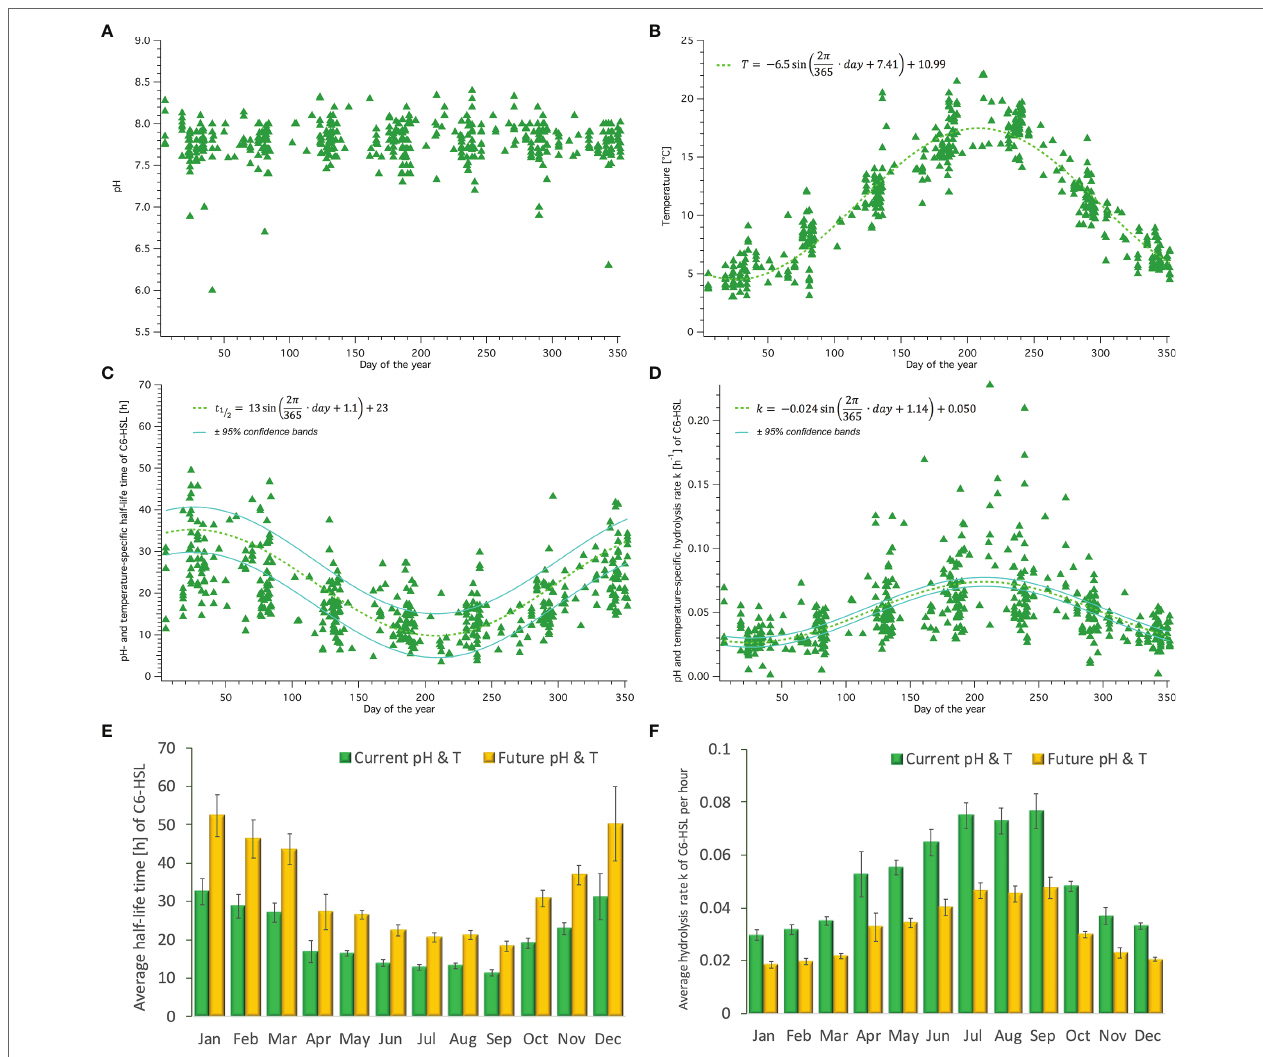
FIGURE 6 | Seasonal fluctuations of pH, temperature, C6-HSL half-life time and hydrolysis rate over the year. (A) pH and (B) temperature measured within the Humber estuary (1995-2005) across the annual cycle. Trend of (C) half-life time and (D) hydrolysis rate of C6-HSL across the year assuming Humber conditions. Average (± SEM) monthly half-life time (E) and hydrolysis rate (F) for current (green) and future (yellow, based on average IPCC prediction of RCP8.5) Humber